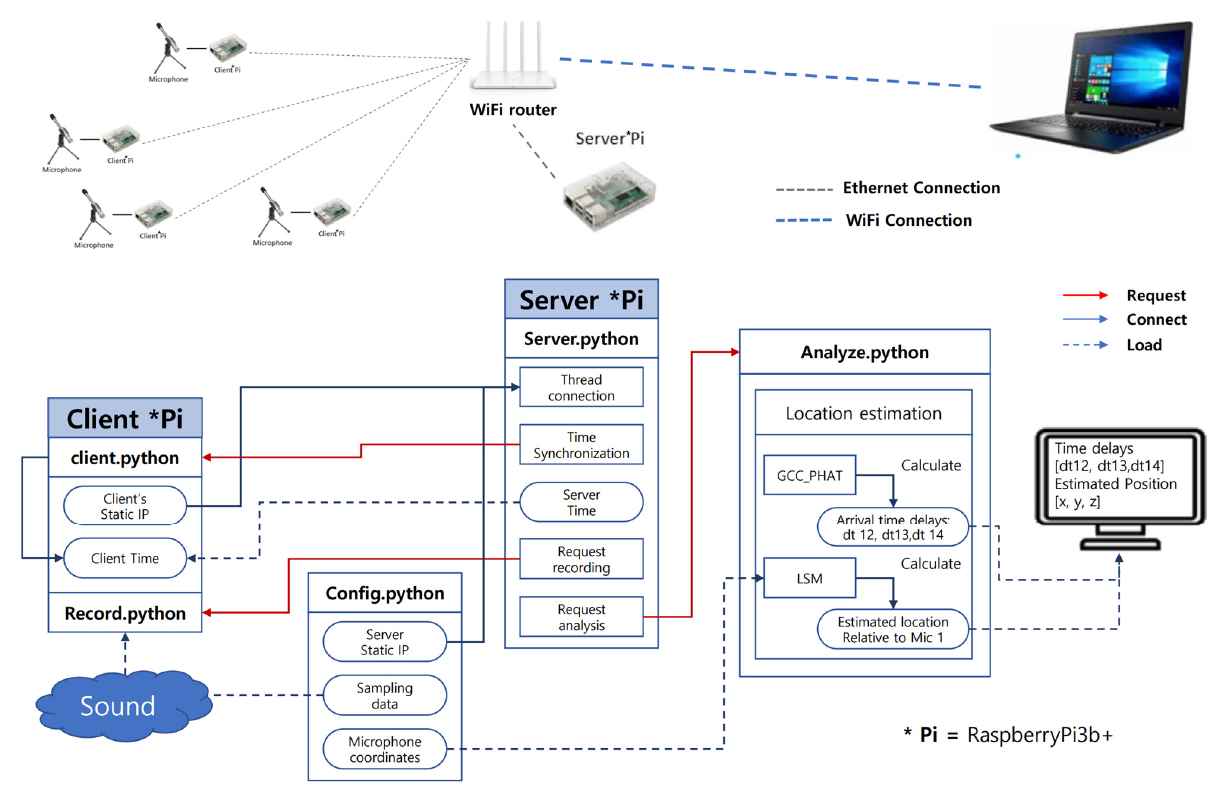
Figure 4. System architecture of CSLF.